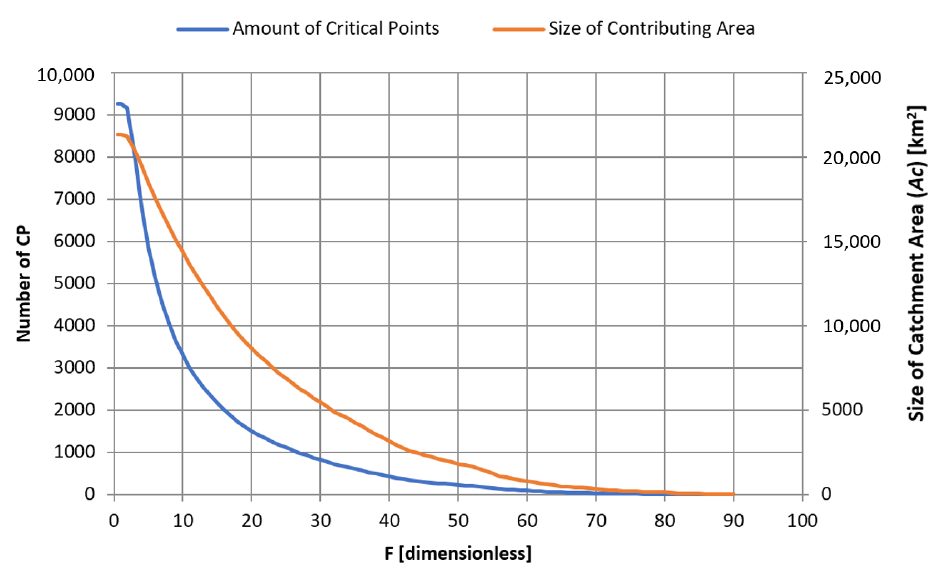
Figure 4. Relations of the number of CPs (blue curve) to the values of the indicator of critical conditions ( F ) and size of catchment areas ( Ac ).